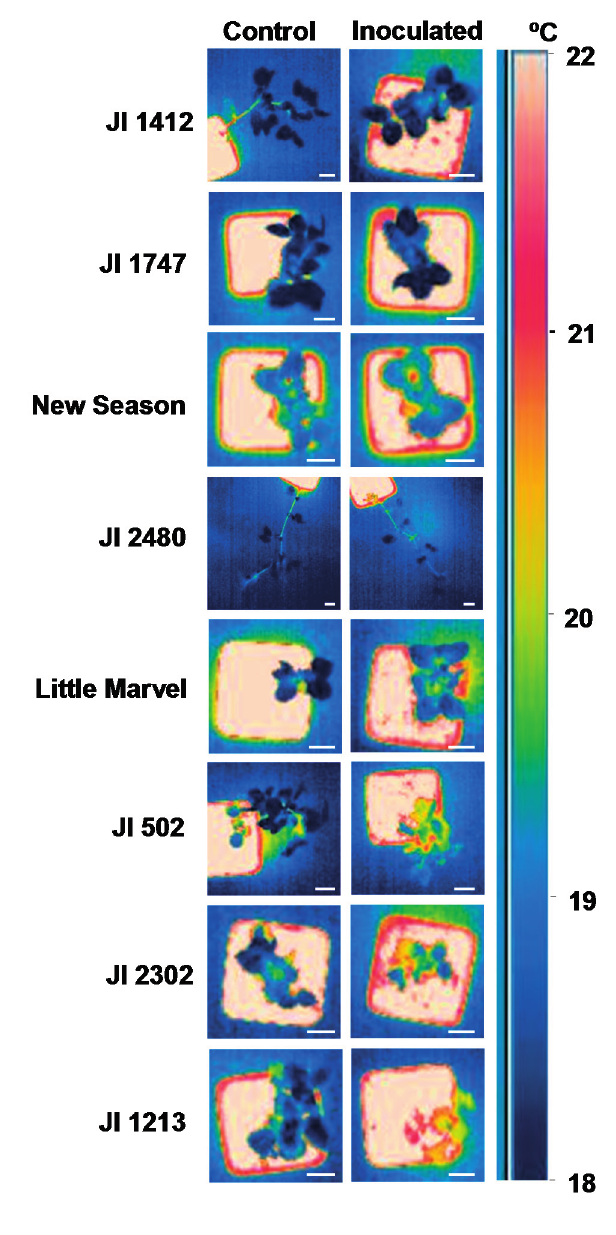
Figure 3. Comparison of the surface leaf temperature between control and inoculated P. sativum plants with F. oxysporum f. sp. pisi (Fop) at 10 days post-inoculation . The figure shows a representative image of each accession maintained non-inoculated (Control, Left ) and inoculated with Fop ( Right ). Scale bars indicate 2